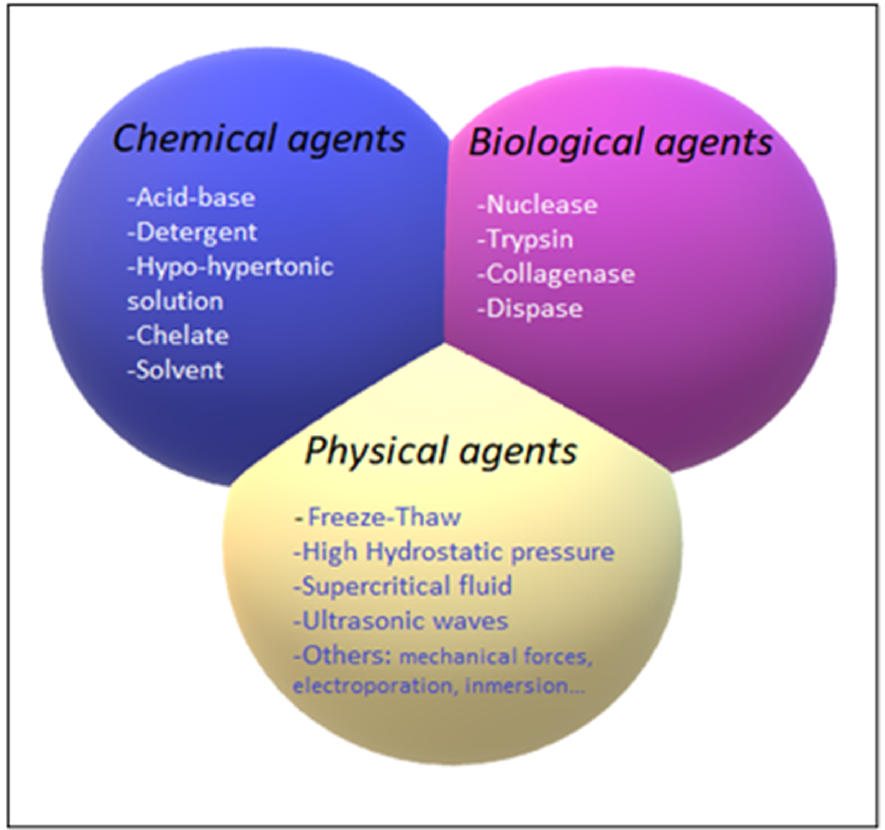
Figure 4. Classification of chemical (blue), biological (pink), and physical (yellow) decellularization agents.